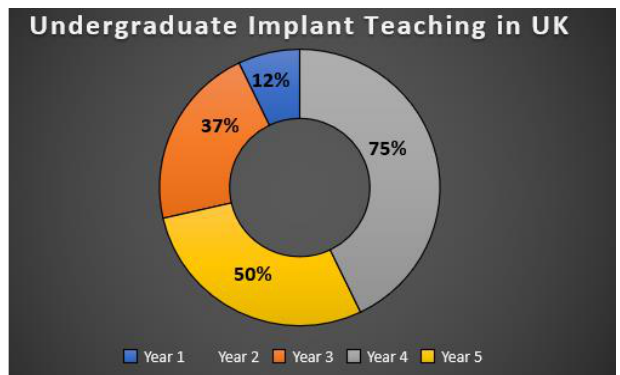
Figure 1. Pie chart shows the percentage of dental implant teaching in UK taught in 5 years of undergraduate dentistry.